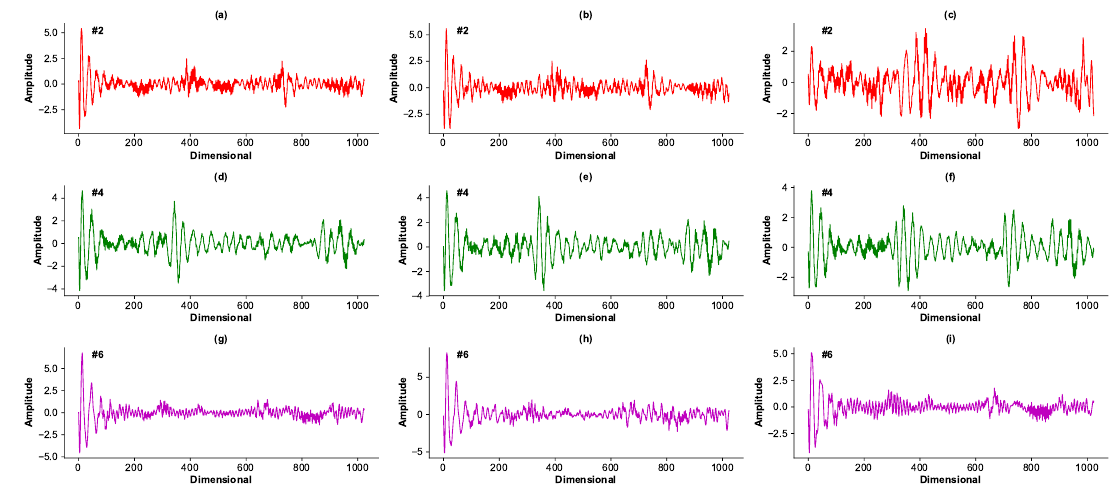
Figure 2. Examples of the input signals. Each signal is 1024-dimensional. ( a – c ) are examples from radar #2; ( d – f ) are examples from radar #4; ( g – i ) are examples from radar #6.